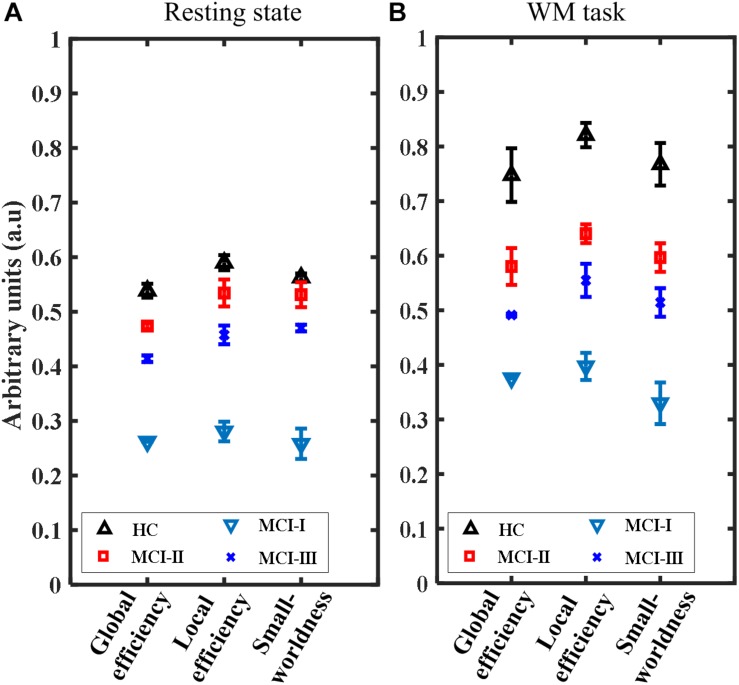
Comparison of the network parameters for HC, MCI-0, MCI-1, and MCI-2 (mean ± standard deviation) at different sparsity threshold levels (range: 0.5–0.05–0.9): (A) RS and (B) WM task.